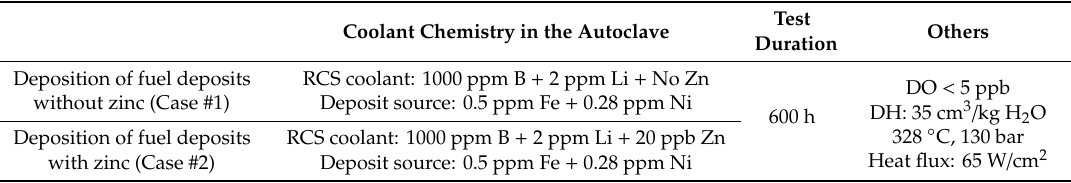
Table 2. Main conditions for the tests for zinc incorporation into newly forming fuel deposits. Coolant Chemistry in the Autoclave